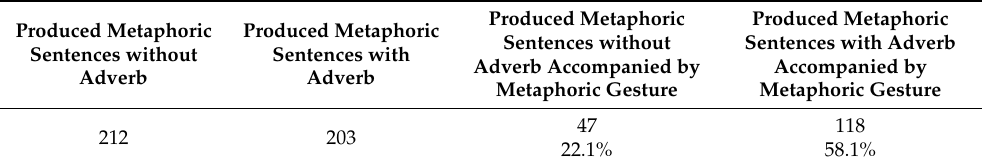
Table 2. Number and proportion of using metaphoric gestures with metaphoric sentences (without or with manner